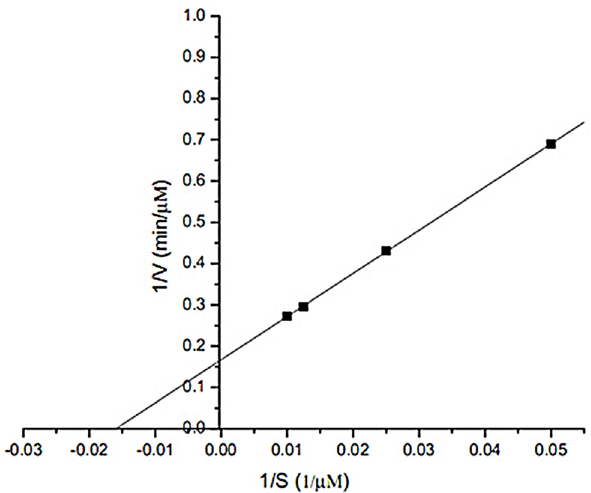
Fig 3. Double reciprocal plot for K m and V max of NOX. Experiment condition: NADH concentration (20, 40, 60, 100, 200 μ M), pH 7.0, 37°C.